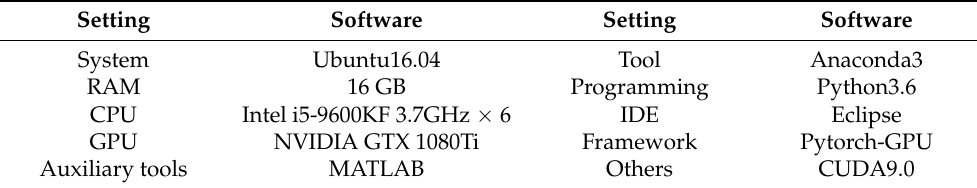
Table 1. Experimental environment.